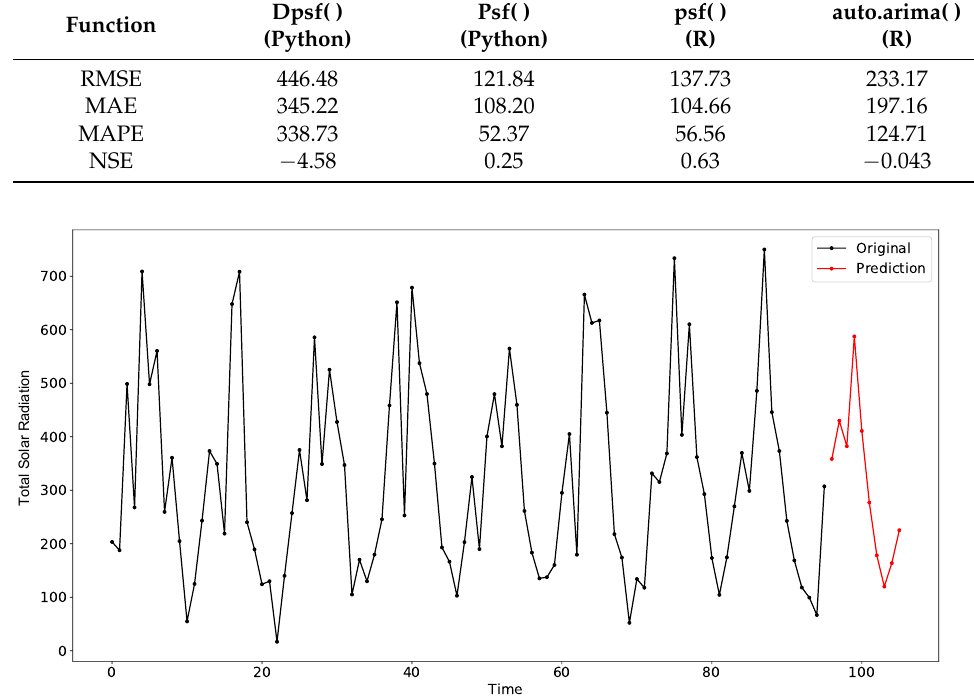
Figure 10. Result of psf_plot() for the “Total Solar Radiation” dataset.